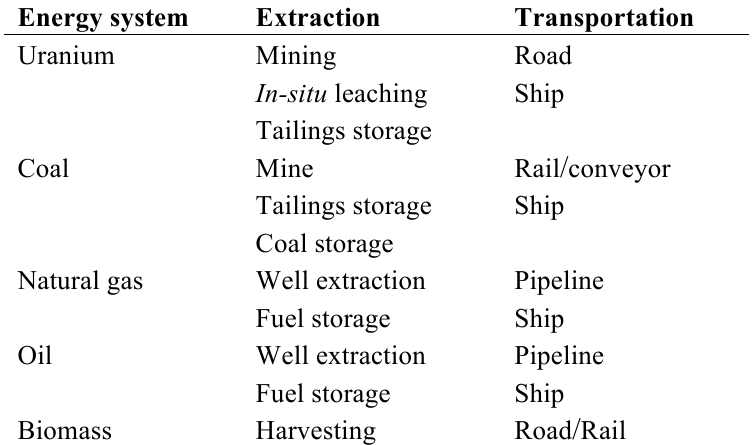
Table 3. Extraction and transportation stages considered for the